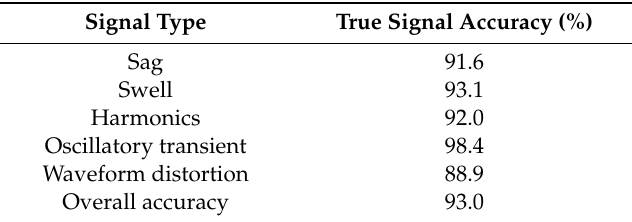
Table 9. True signal classification